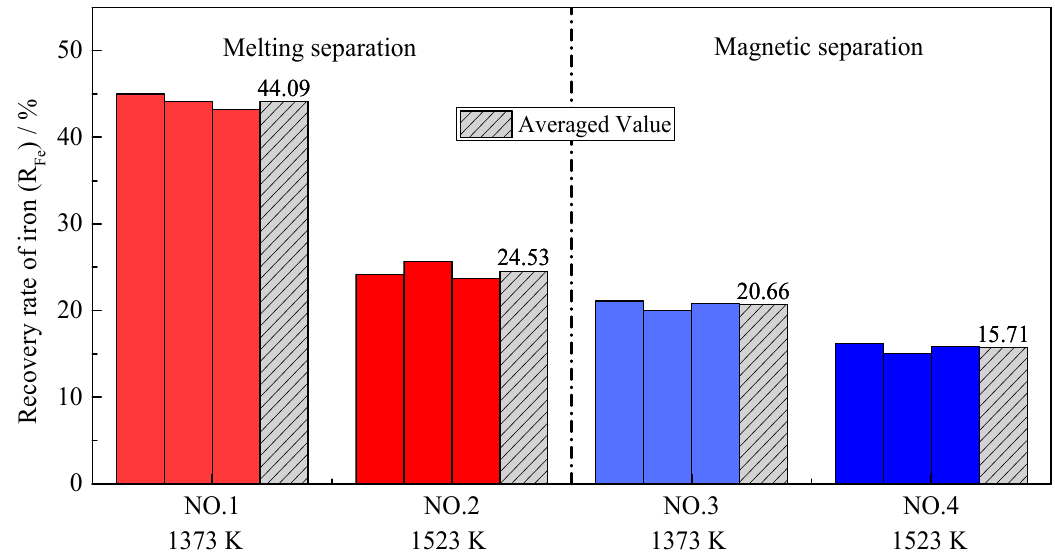
Figure 7. Recovery rate for iron with different pre-reduction temperatures and different separation processes.